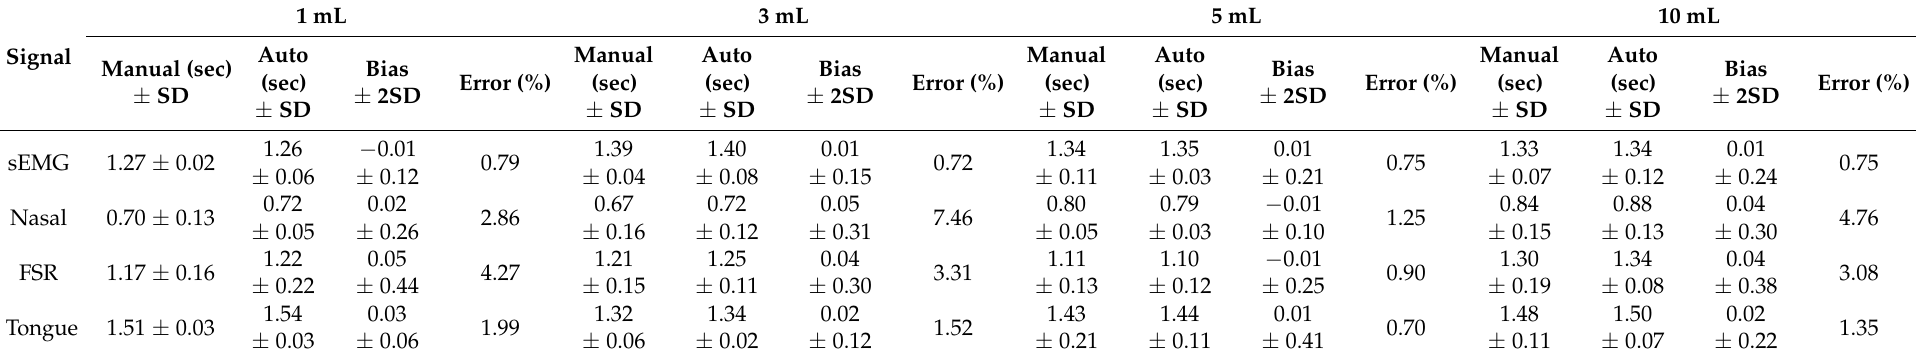
Table 4. Verification results of the autodetection program compared with the manual